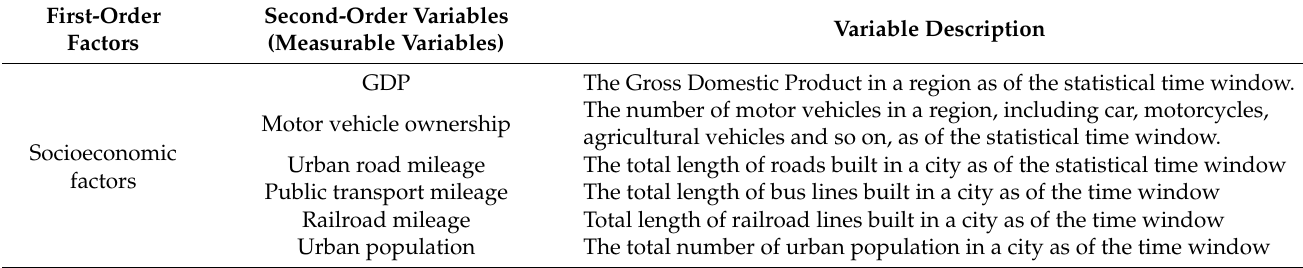
Table 4. The socioeconomic factors influencing on traffic congestion.